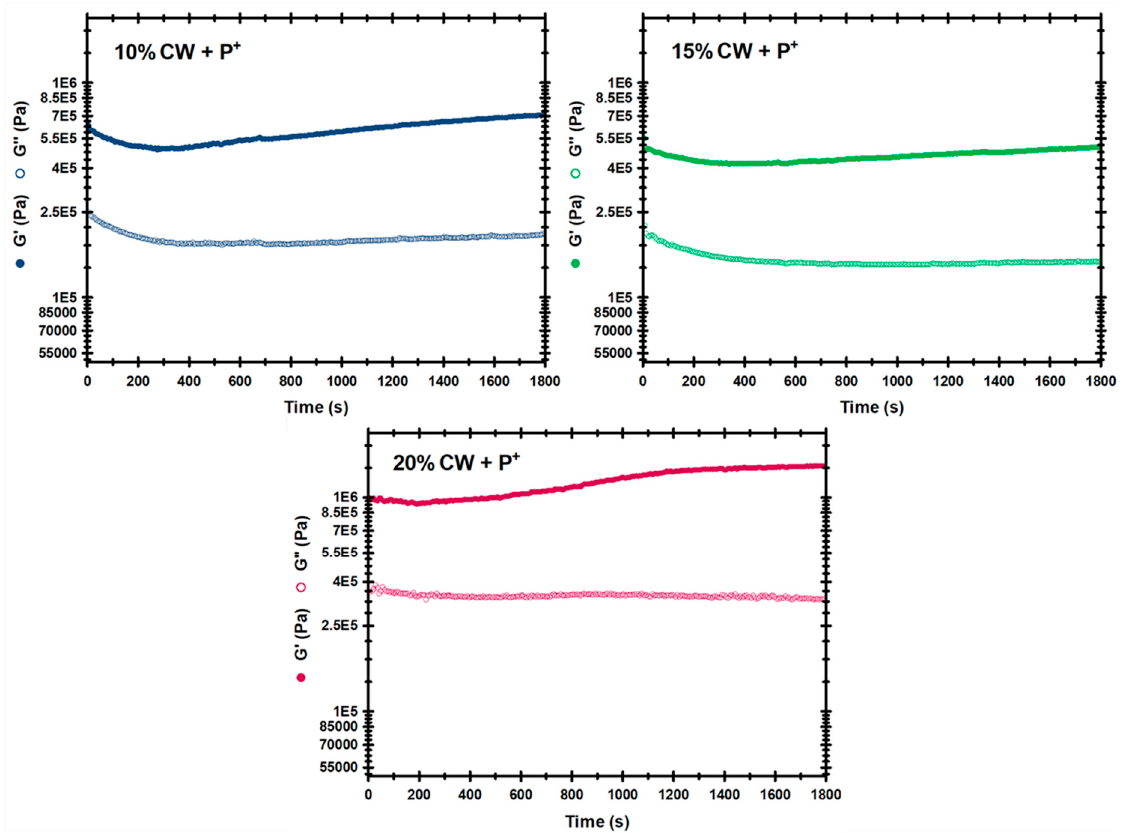
Figure 3. Time sweeps of the oleogels developed with different concentrations of candelilla wax (CW) with the addition of phosphorus (P + ) at 40 °C.